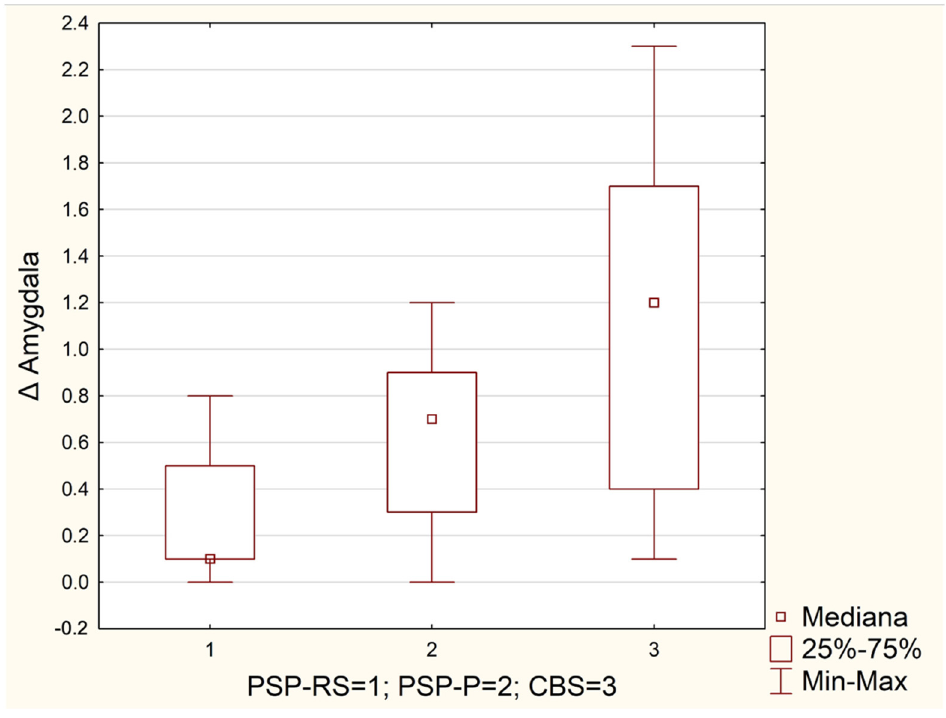
Figure 1. Δ Amygdala in tauopathic Parkinsonian